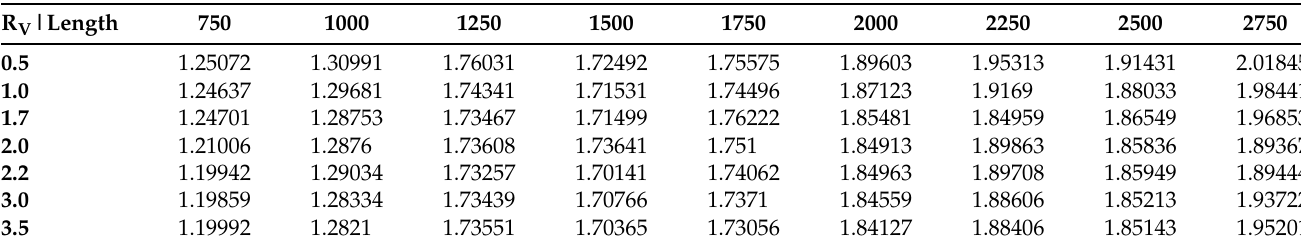
Table A13. Execution times in milliseconds on GPU with cable structure for 30,000 time-steps (1.5 s); R V on the Left and number of cells (length) on the Top .